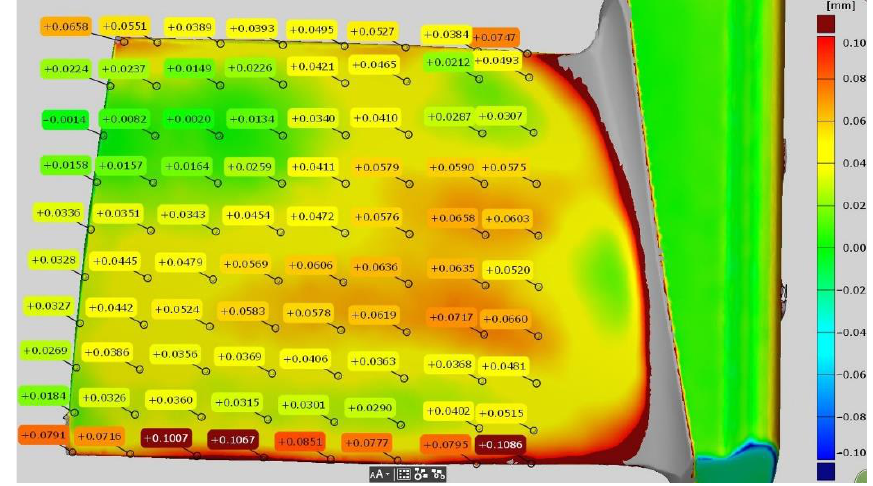
Figure 7. Determined allowances at 80 points on the blade.